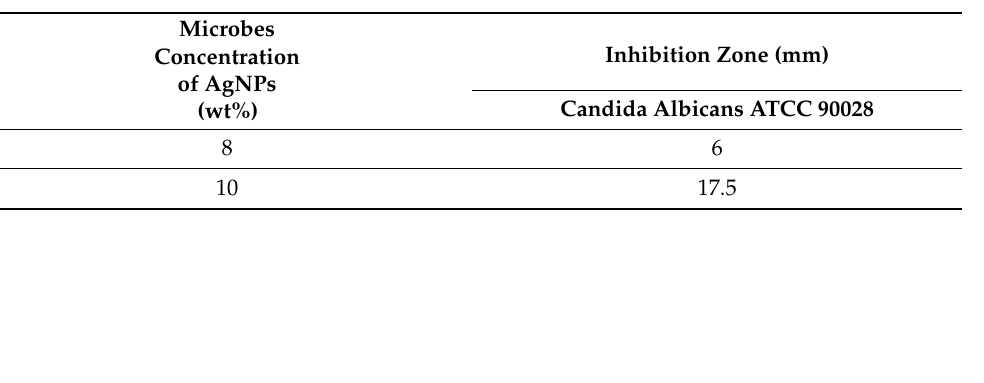
Table 5. Antifungal study of kenaf/HDPE